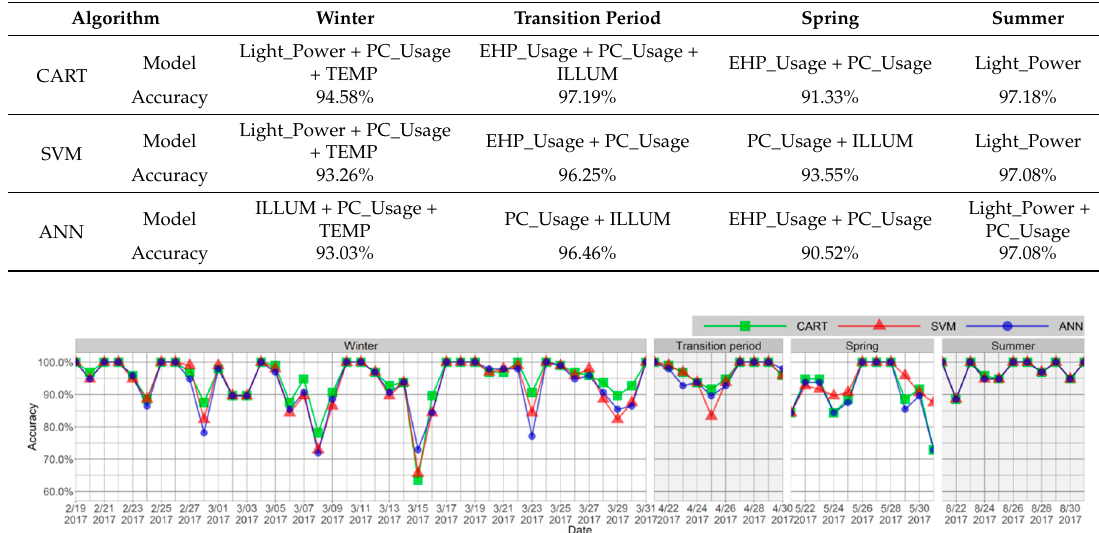
Figure 5. Seasonal changes of daily accuracy of selected final occupancy estimation models with three classification algorithms.